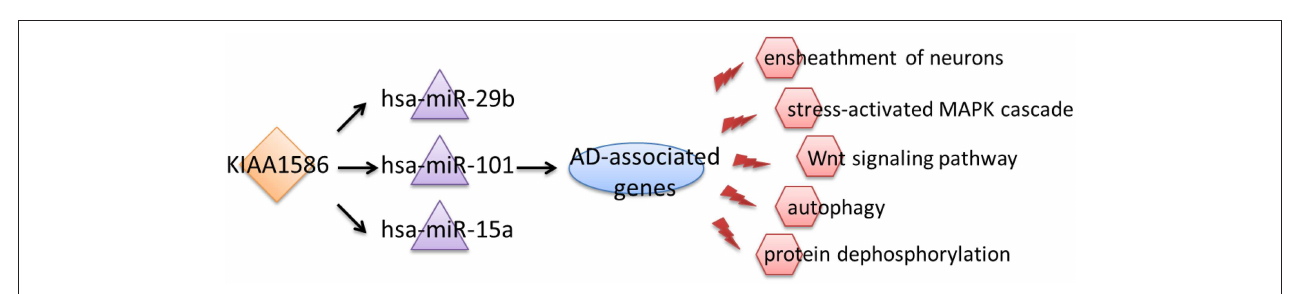
FIGURE 4 | A schematic diagram about circular RNAs, miRNAs, and AD pathologic mechanisms.